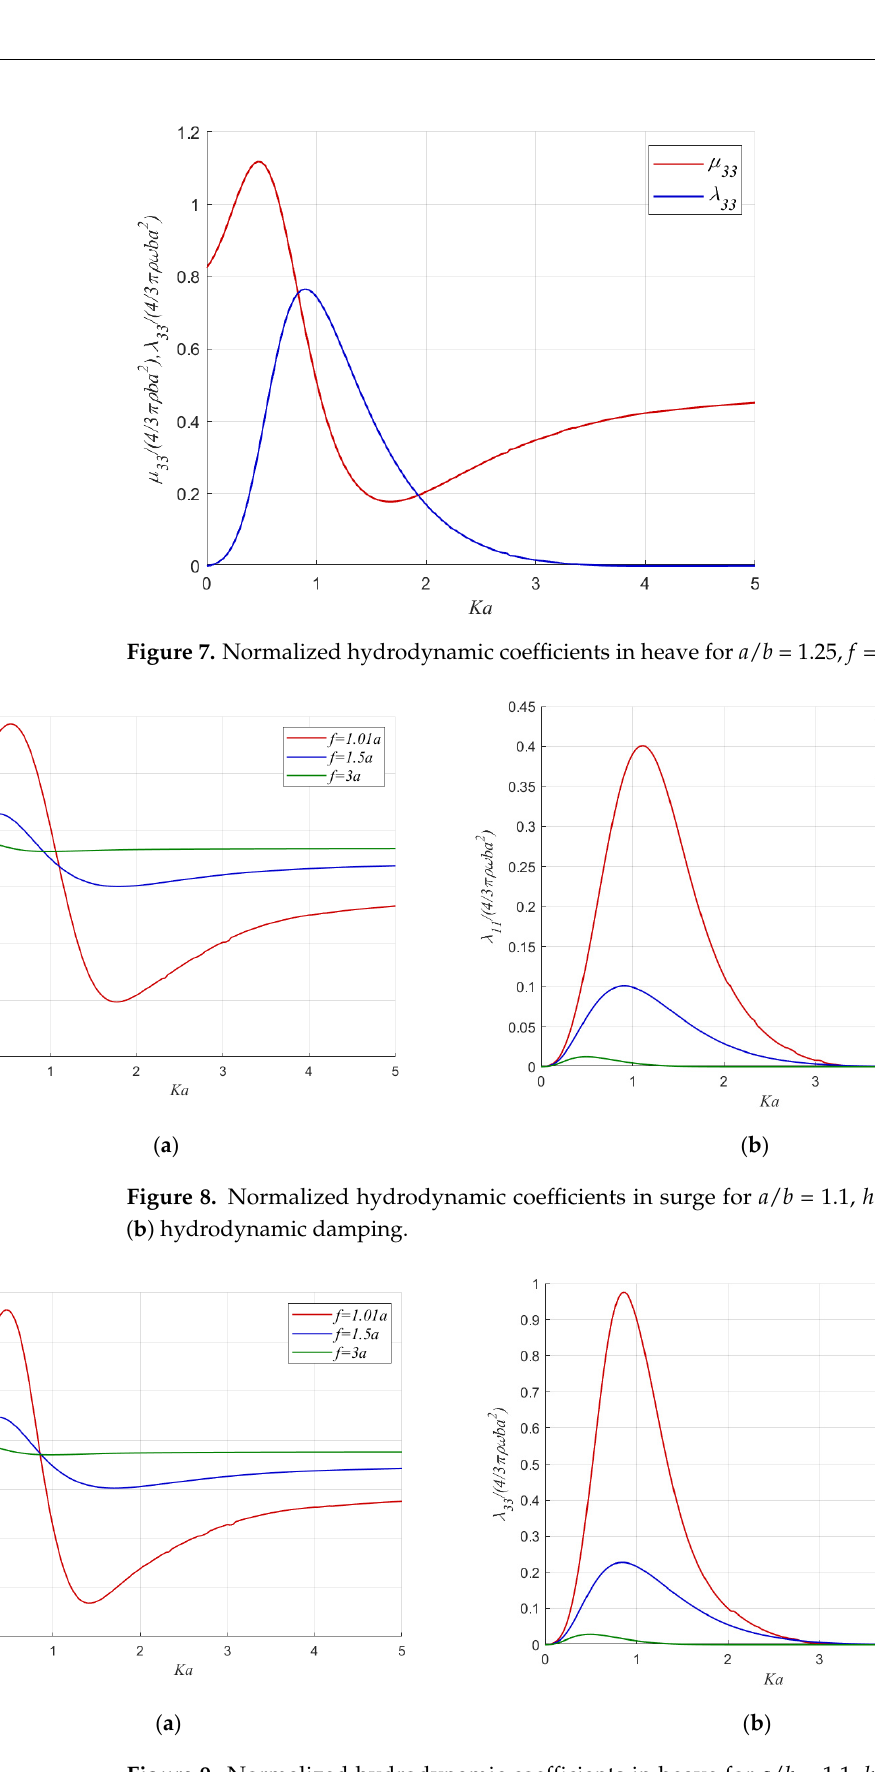
Figure 9. Normalized hydrodynamic coefficients in heave for a/b = 1.1, h = 10a: ( a ) added mass; ( b ) hydrodynamic damping.